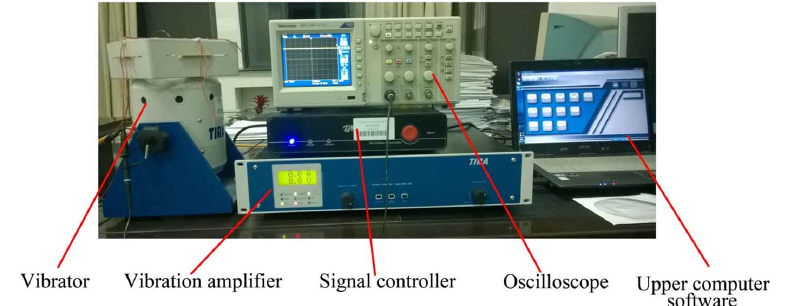
Figure 11. Vibration test rig.